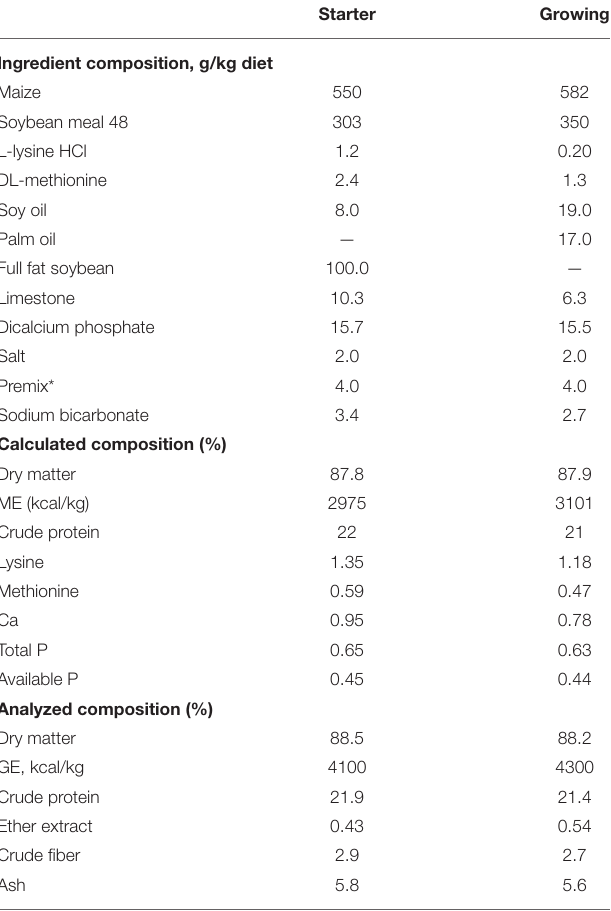
TABLE 1 | Dietary compositions and nutrient levels (% as fed-basis, unless otherwise indicated) of the basal